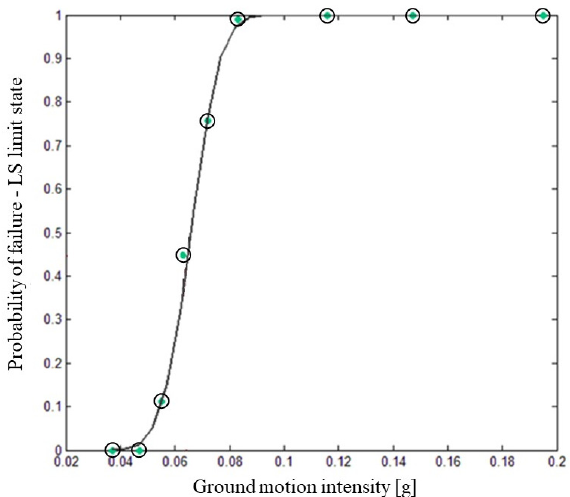
Figure 2. Fragility curve by regression of points related to nine seismic intensities.